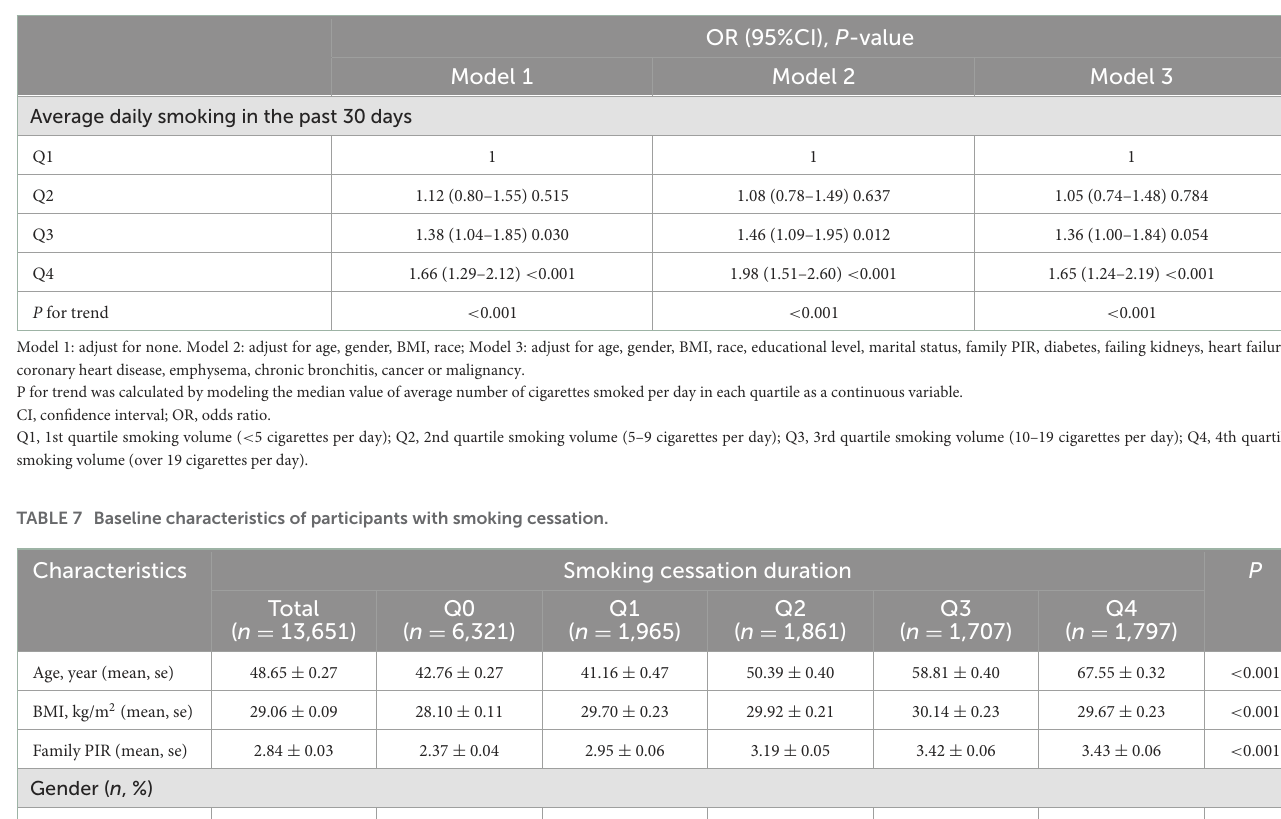
TABLE 6 Average daily smoking in the past 30 days as categorical variables to analyze the relationship between average daily smoking and depression in adults ( n = 6,264) in NHANES (2005–2018).